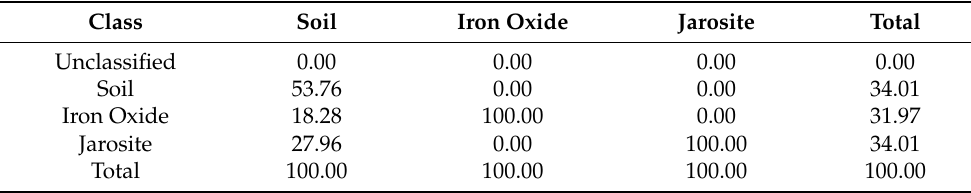
Table A11. November 2018 spectral angle mapper. Overall accuracy points: 104/147, overall accuracy: 70%, kappa coefficient: 0.5595.